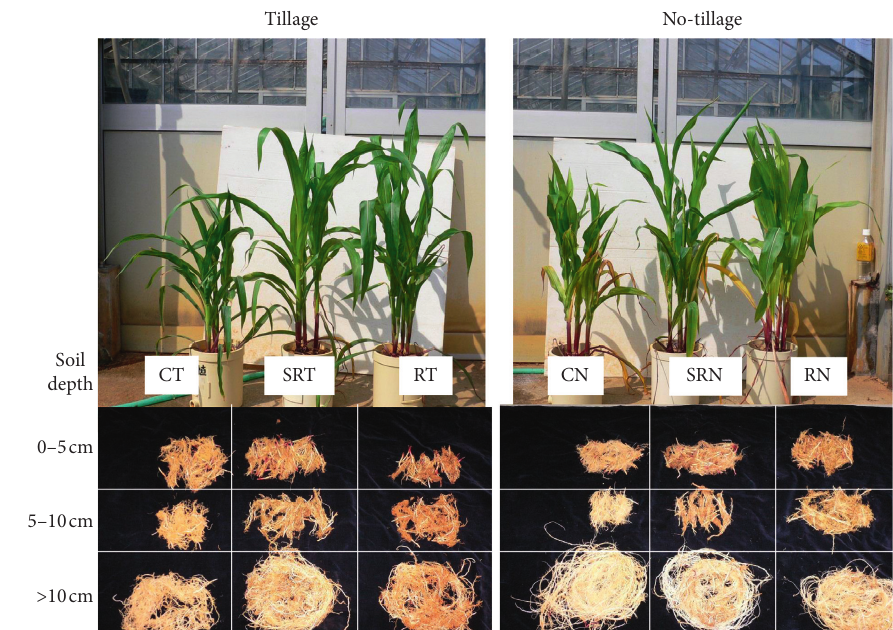
Figure 4: Corn growth on the pot experiment with tillage and no-tillage at 56 DAT. CT without addition (as the control) for tillage. SRT: shoot-root addition with tillage; CN: without addition (as the control) for no-tillage. SRN: shoot-root addition with no-tillage; RN: root addition with no